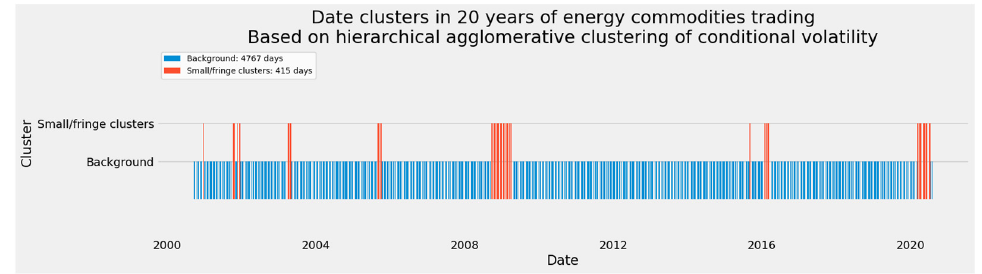
Figure 28. Hierarchical agglomerative clustering of energy-related markets—A simplified timeline aggregating the smallest six among 12 clusters.